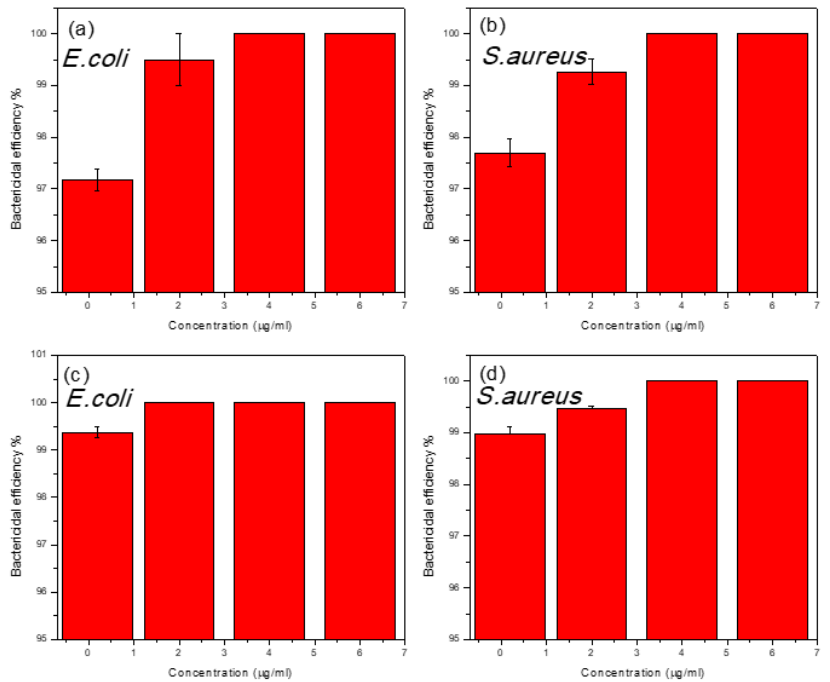
Figure 2. The bactericidal efficiency of ( a , b ) E. coli and S. aureus under simulated light. ( c , d ) E. coli and S. aureus exposed to sunlight for 10 min by Ag 9 (SiO 4 ) 2 NO 3